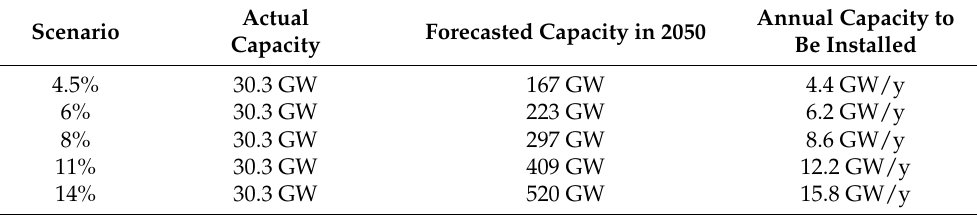
Table 3. Main assumption per scenario. PHS capacity needed in order to reach the goals by